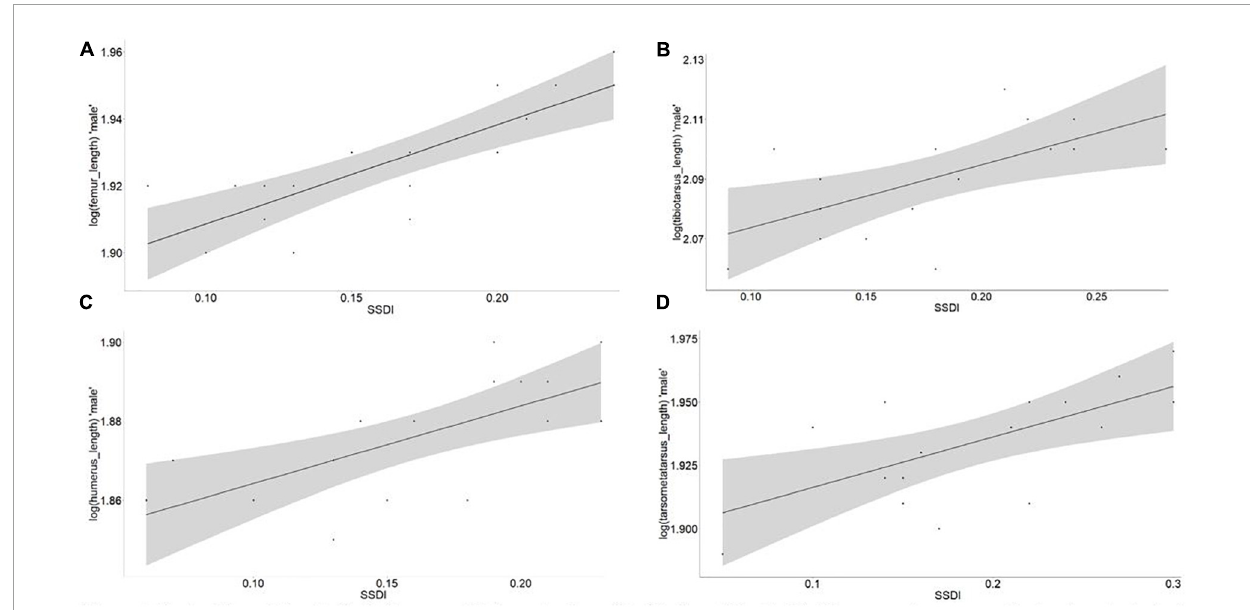
FIGURE9 Test of Rensch’s male for indigenous chicken osteology (hindlimb and forelimb). The regression was run log (male osteological trait) as dependent variable and SSDI value (Lovich and Gibbons, 1992) was calculated with the following formula ([Male/Female] – 1) as independent variable. (A) Femur, R 2 = 0.68, slope = 2.29, P -value = 0.0001; (B) tibiotarsus, R 2 = 0.38, slope = 1.81, P -value = 0.0001; (C) humerus, R 2 = 0.47, slope = 2.37, P -value = 0.0001; (D) tarsometatarsus length, R 2 = 0.40, slope = 1.99, P -value =